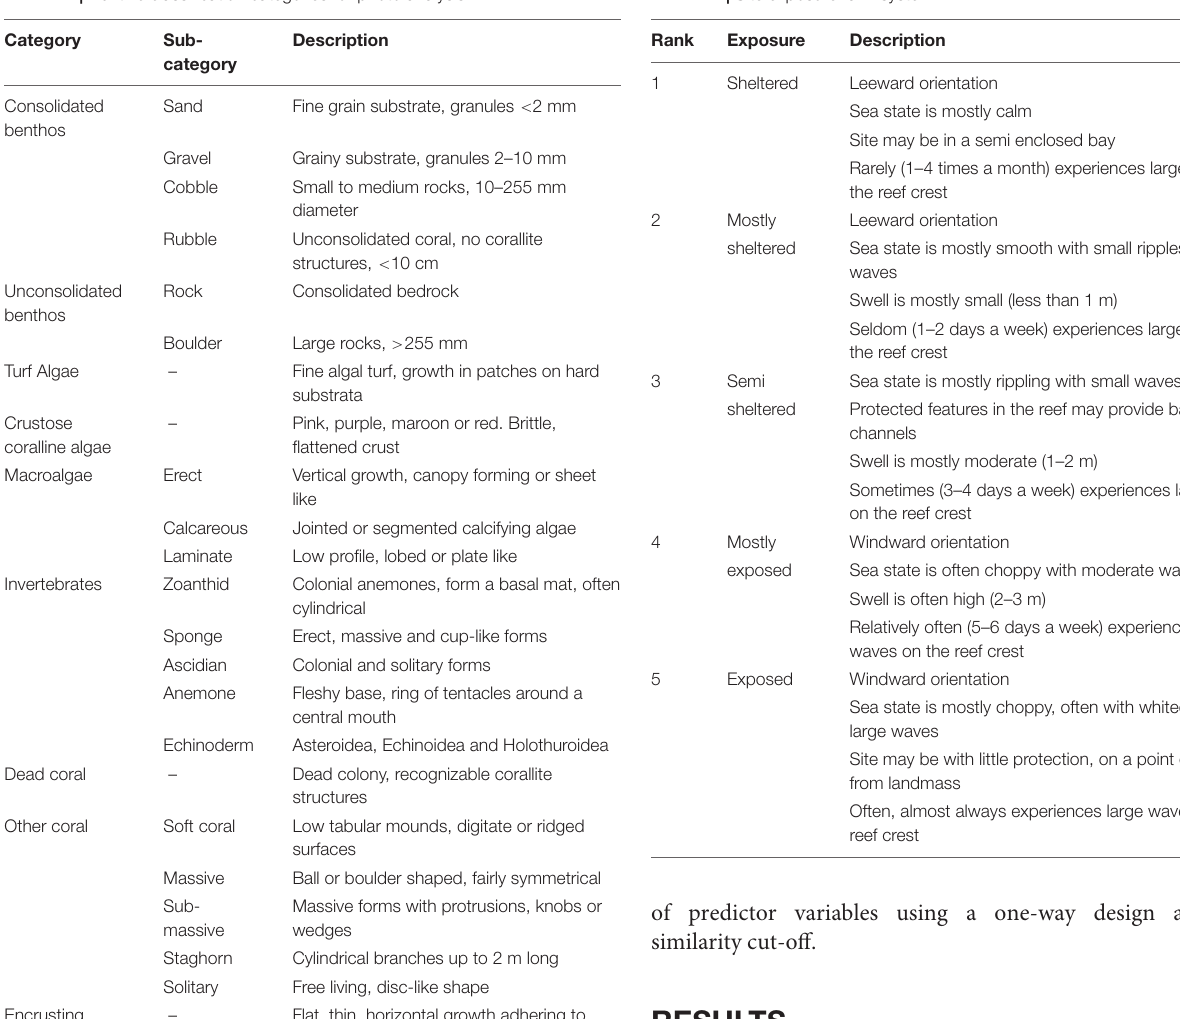
TABLE 1 | Benthic classification categories for photo